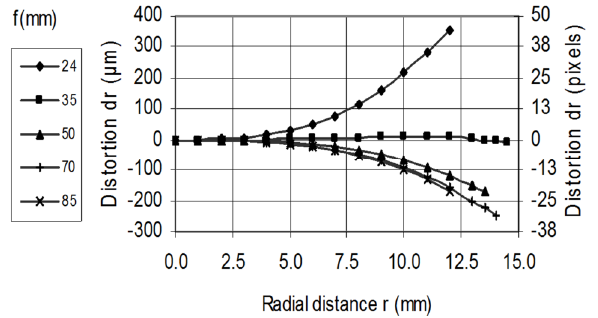
Figure 1. Variation of Gaussian radial distortion with zoom setting for a Nikkor 24-85mm zoom lens.